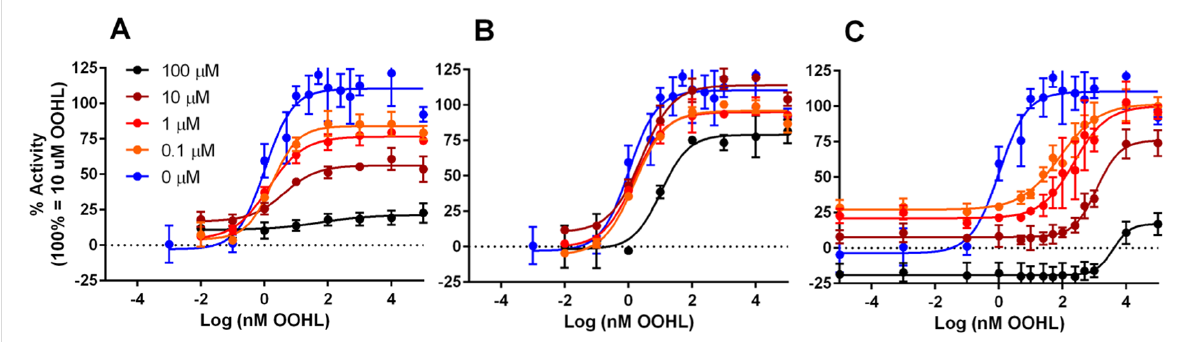
Figure 5: Dose–response activity curves for OOHL ( 2 ) in competition against various concentrations of synthetic compounds in the S. Typhimurium SdiA reporter. (A) Data for compound F45 , (B), R8 , and (C) 11 . Figure legend in panel A applies to panels B and C. All assays are biological tripli- cates of technical triplicates. See Experimental section for full assay